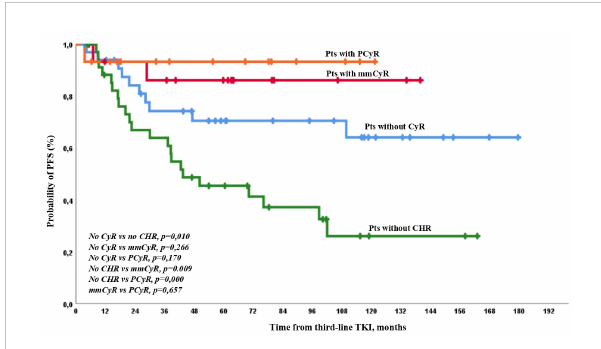
FIGURE 4 PFS on third-line TKI therapy according to the depth of response at baseline. There were only 1/35 (3%) and 26/65 (40%) cases of AP/BP among patients who achieved or did not achieve CCyR on third-line TKI therapy ( p = 0.0001).